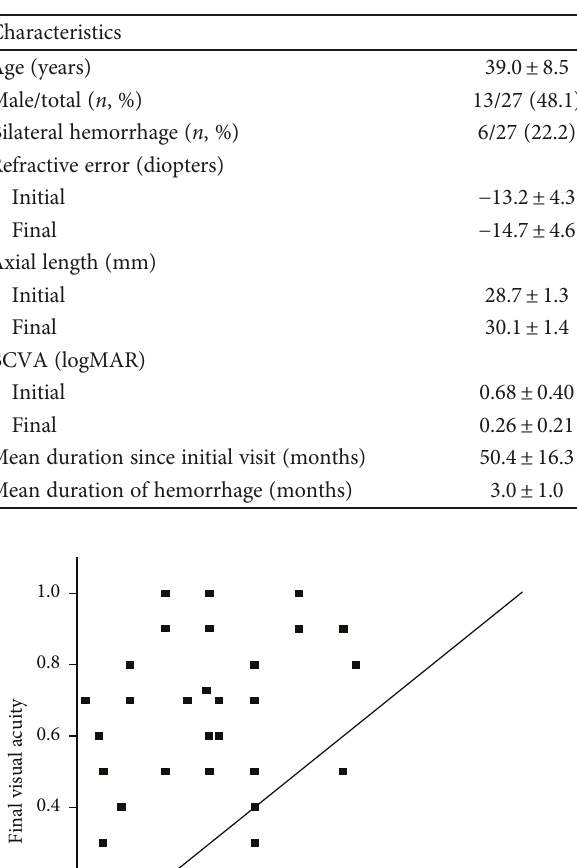
Table 1: Patient clinical characteristics ( n = 27 ).